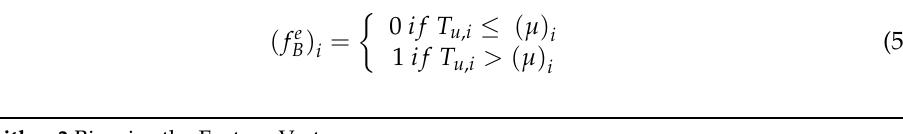
Algorithm 3 Binarize the Feature